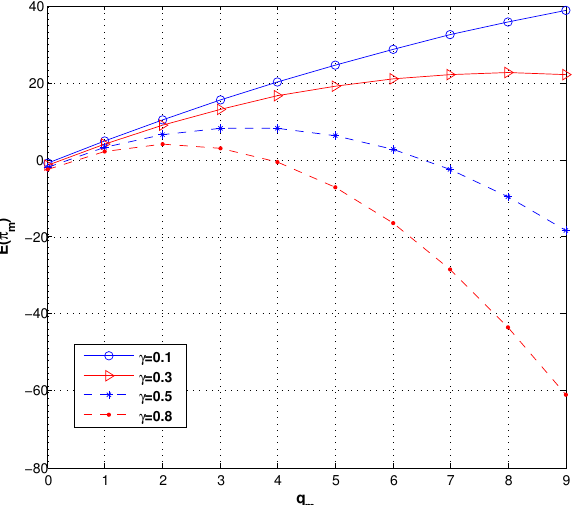
Figure 5. The expected profit of the manufacturer under different γ